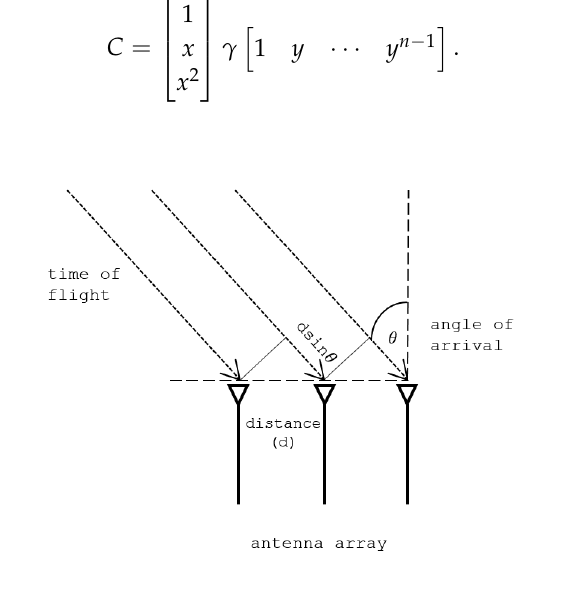
Figure 1. Signal impinging on a linear antenna